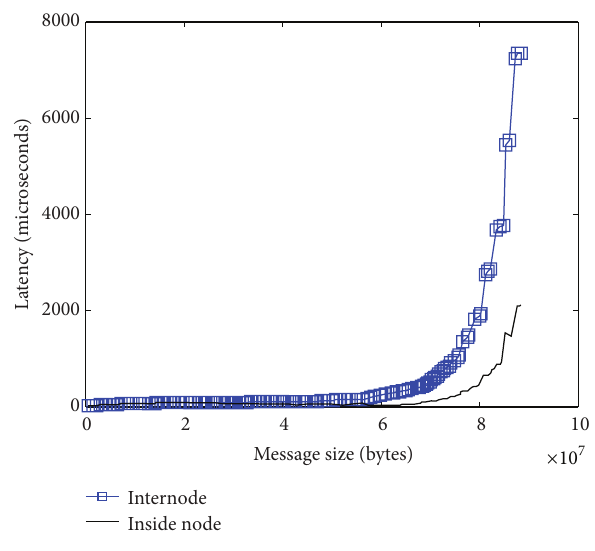
Figure 3: Network latency of